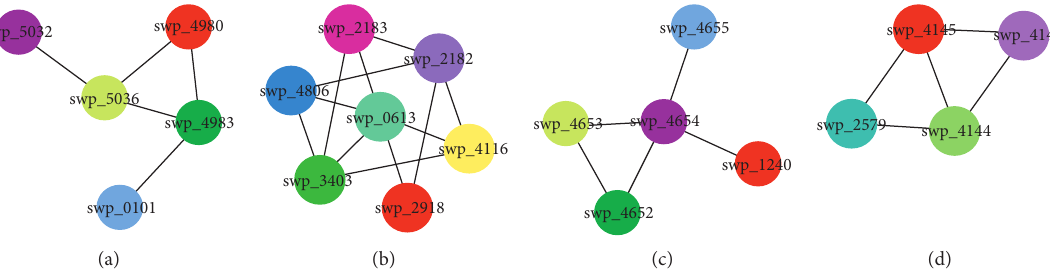
Figure 5: Electron transfer-relevant modules underlying the various environmental conditions. (a) Molybdenum cofactor biosynthesis module under the cold shock condition, (b) multihaem cytochrome module under the heat shock condition, (c) NrfD family module under the high pressure condition, and (d) cytochrome c oxidase module under the salt shock